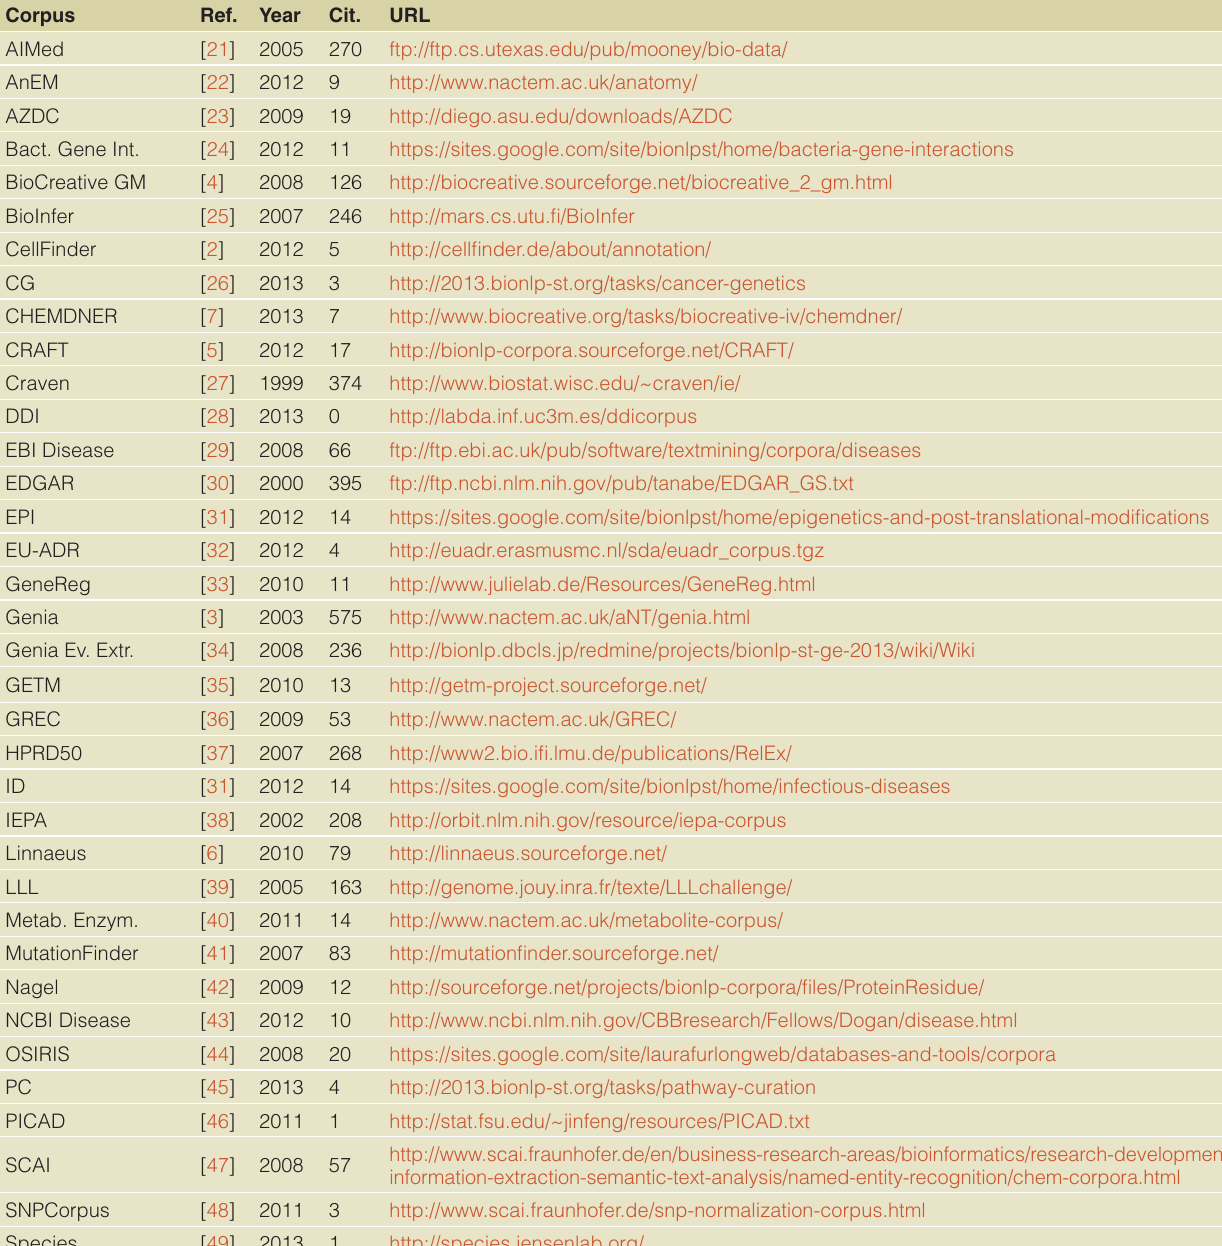
Table 1. Overview of the corpora: main publication, year of publication, citations in Google Scholar (as December-2013) and the URL are shown for each corpus. Corpus Ref. Year